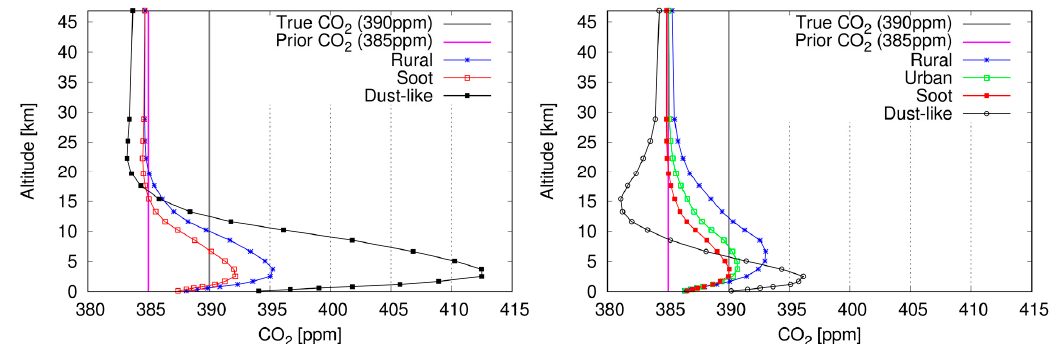
Figure 3. Vertical CO 2 profile ( a ), averaging kernel ( b ), and column averaging kernel ( c ) retrieved by the optimized method.